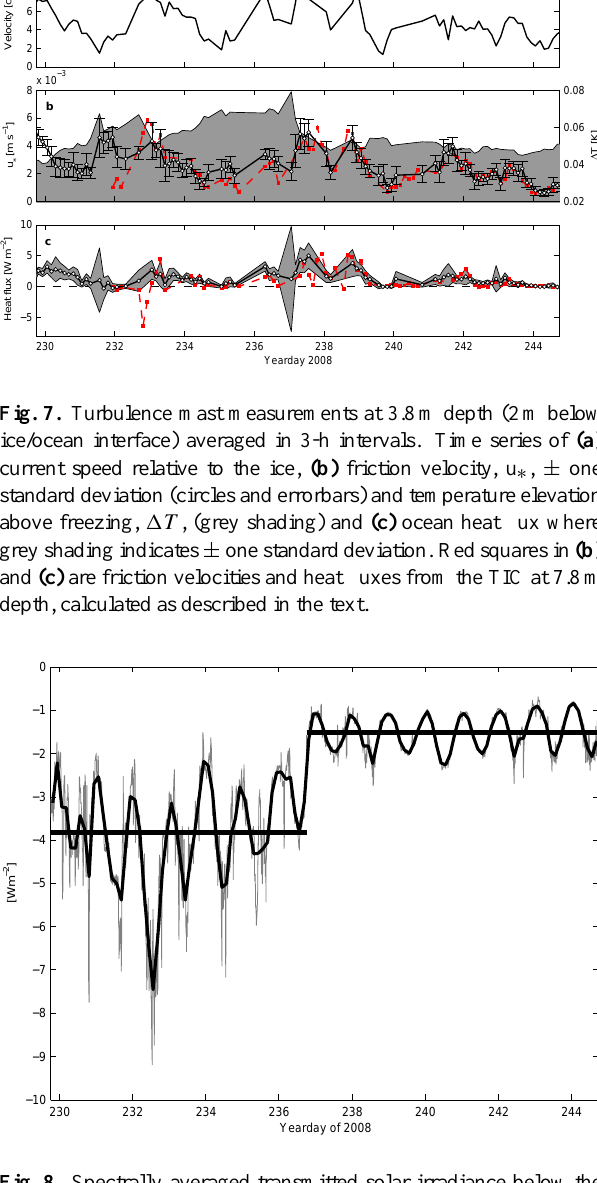
Fig. 8. Spectrally averaged transmitted solar irradiance below the sea-ice at the ocean measurements site. Black line is a 3-h running mean and horizontal lines indicate averages for periods before and after the change in surface conditions occurring on doy 236.75. Pos- itive fluxes are upwards; hence negative fluxes represent an input of energy to the ocean mixed